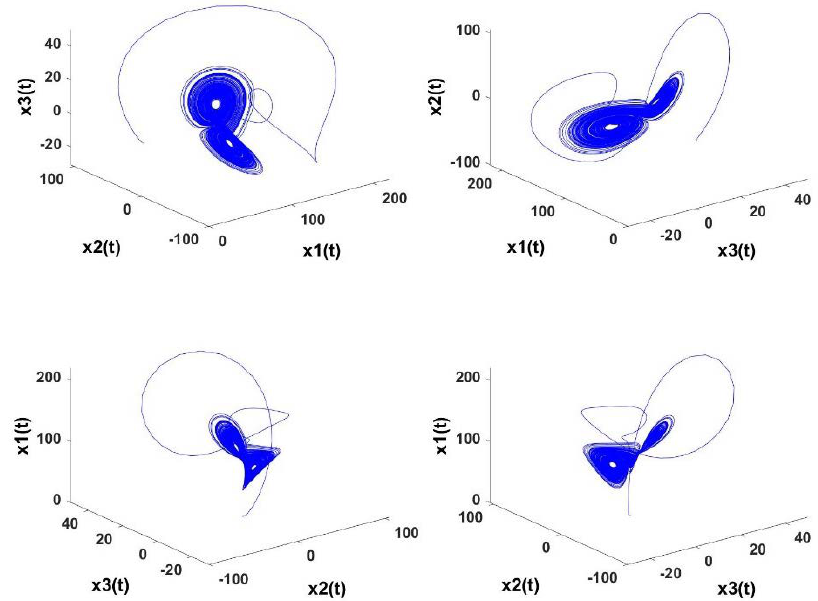
Figure 1. Chaotic attractors of the master system (29) when ( a , b ) = ( 100,10 ) and p =